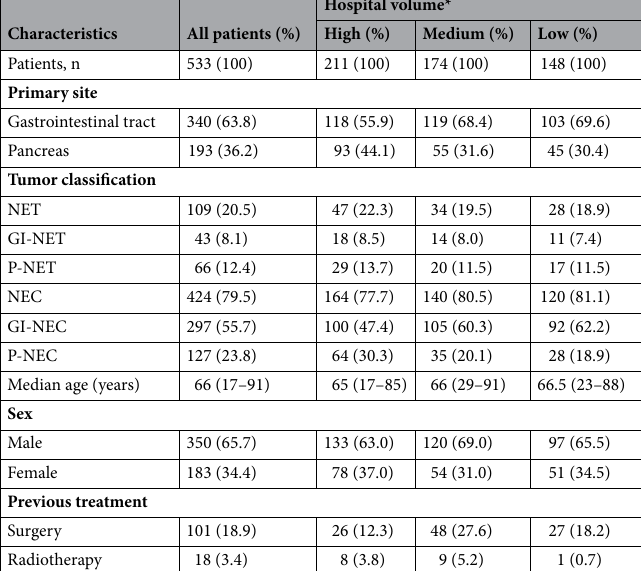
High-volume n = 18